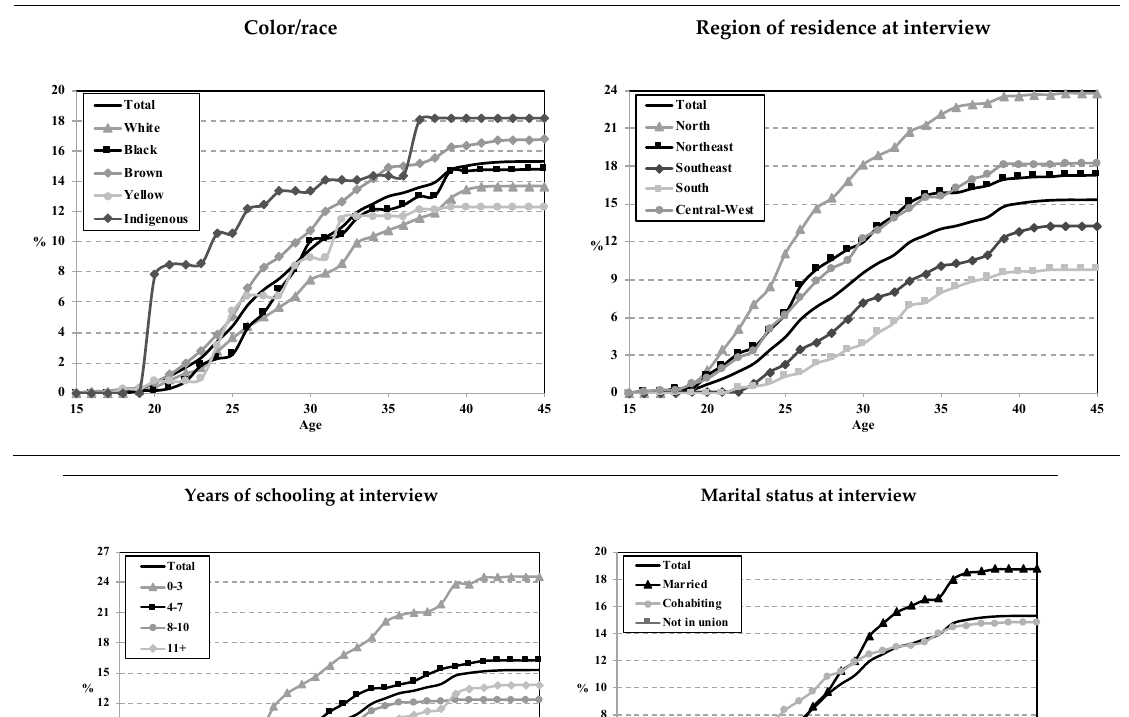
Figure 1. Cumulative percentage distribution of sterilized women by age at the moment of sterilization, Brazil, January 2001 to July 2007. Note: Parity at delivery, type of delivery, and place of delivery relate to information from the last birth. Source: 2006 Brazilian National Survey on Demography and Health of Women and Children (PNDS).